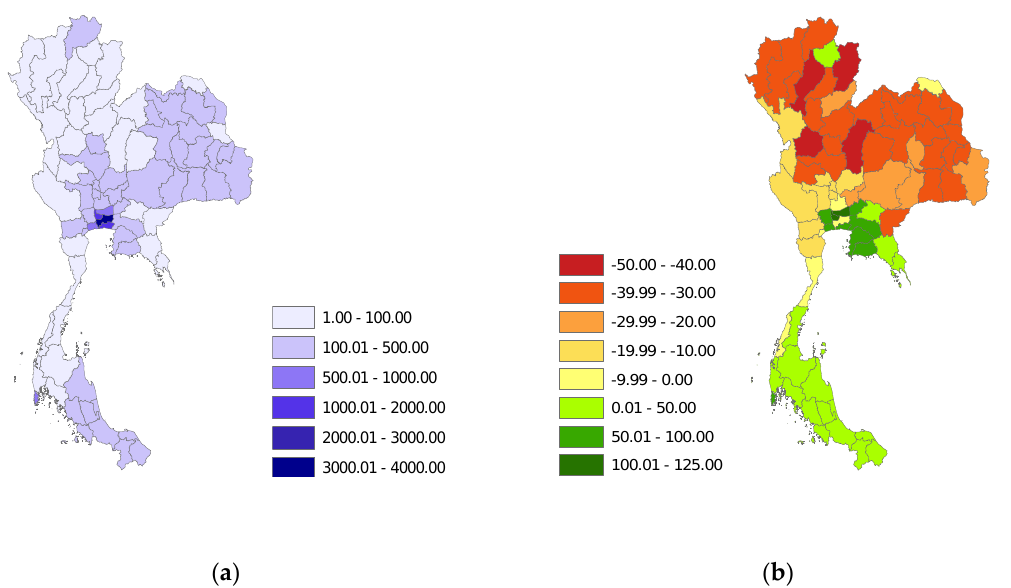
Figure 2. Projected changes in total annual rainfall (mm) during 2046–2055 under RCP 4.5 and RCP8.5 from baseline during 1992–2016.